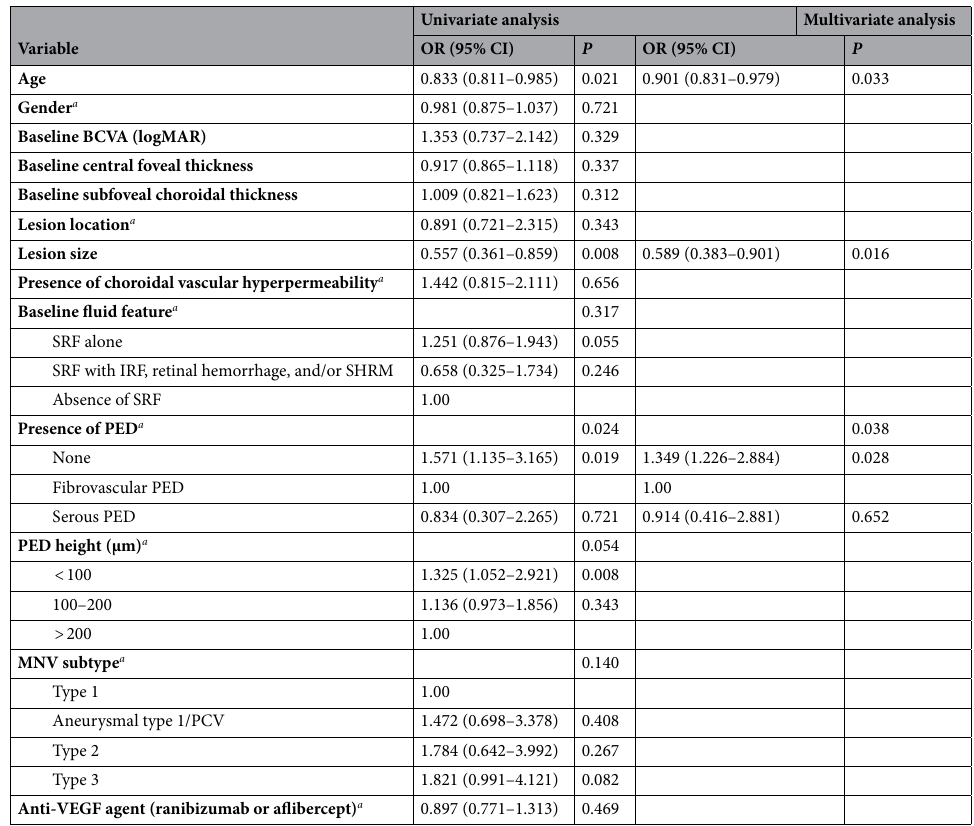
Table 3. Association between baseline characteristics and the absence of exudative recurrence: logistic regression analysis. AMD age-related macular degeneration, BCVA best-corrected visual acuity, CI confidence interval, logMAR logarithm of the minimum angle of resolution, MNV macular neovascularization, OR odds ratio, PCV polypoidal choroidal vasculopathy, PED pigment epithelial detachment, SRF subretinal fluid, VEGF vascular endothelial growth factor. a Categorical